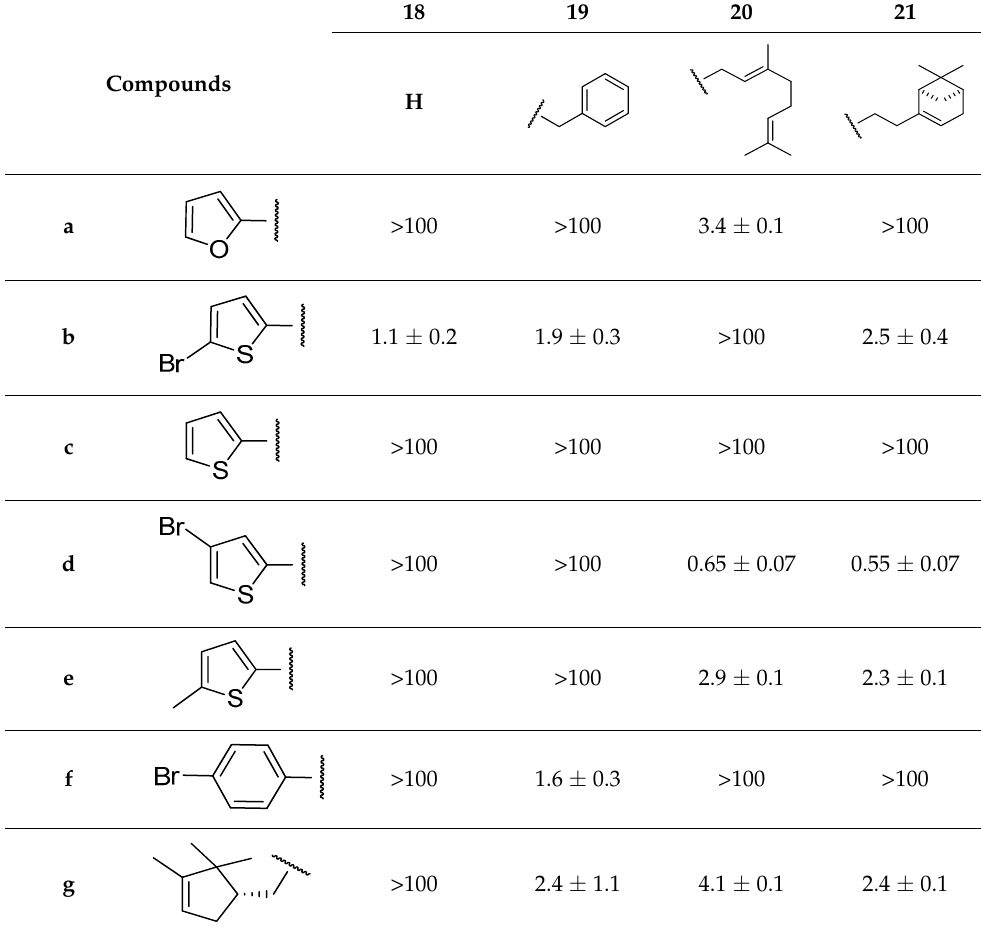
Compounds Compounds